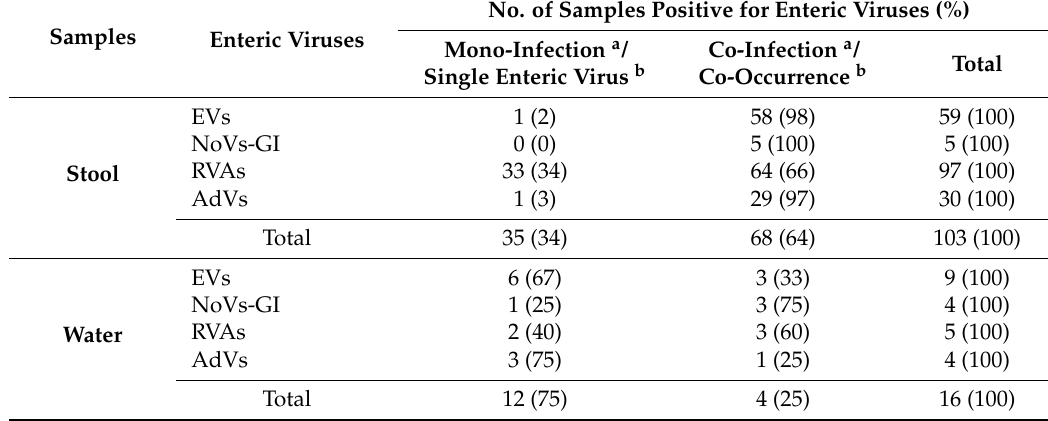
Table 3. Co-occurrence of enteric viruses in stool and water samples.